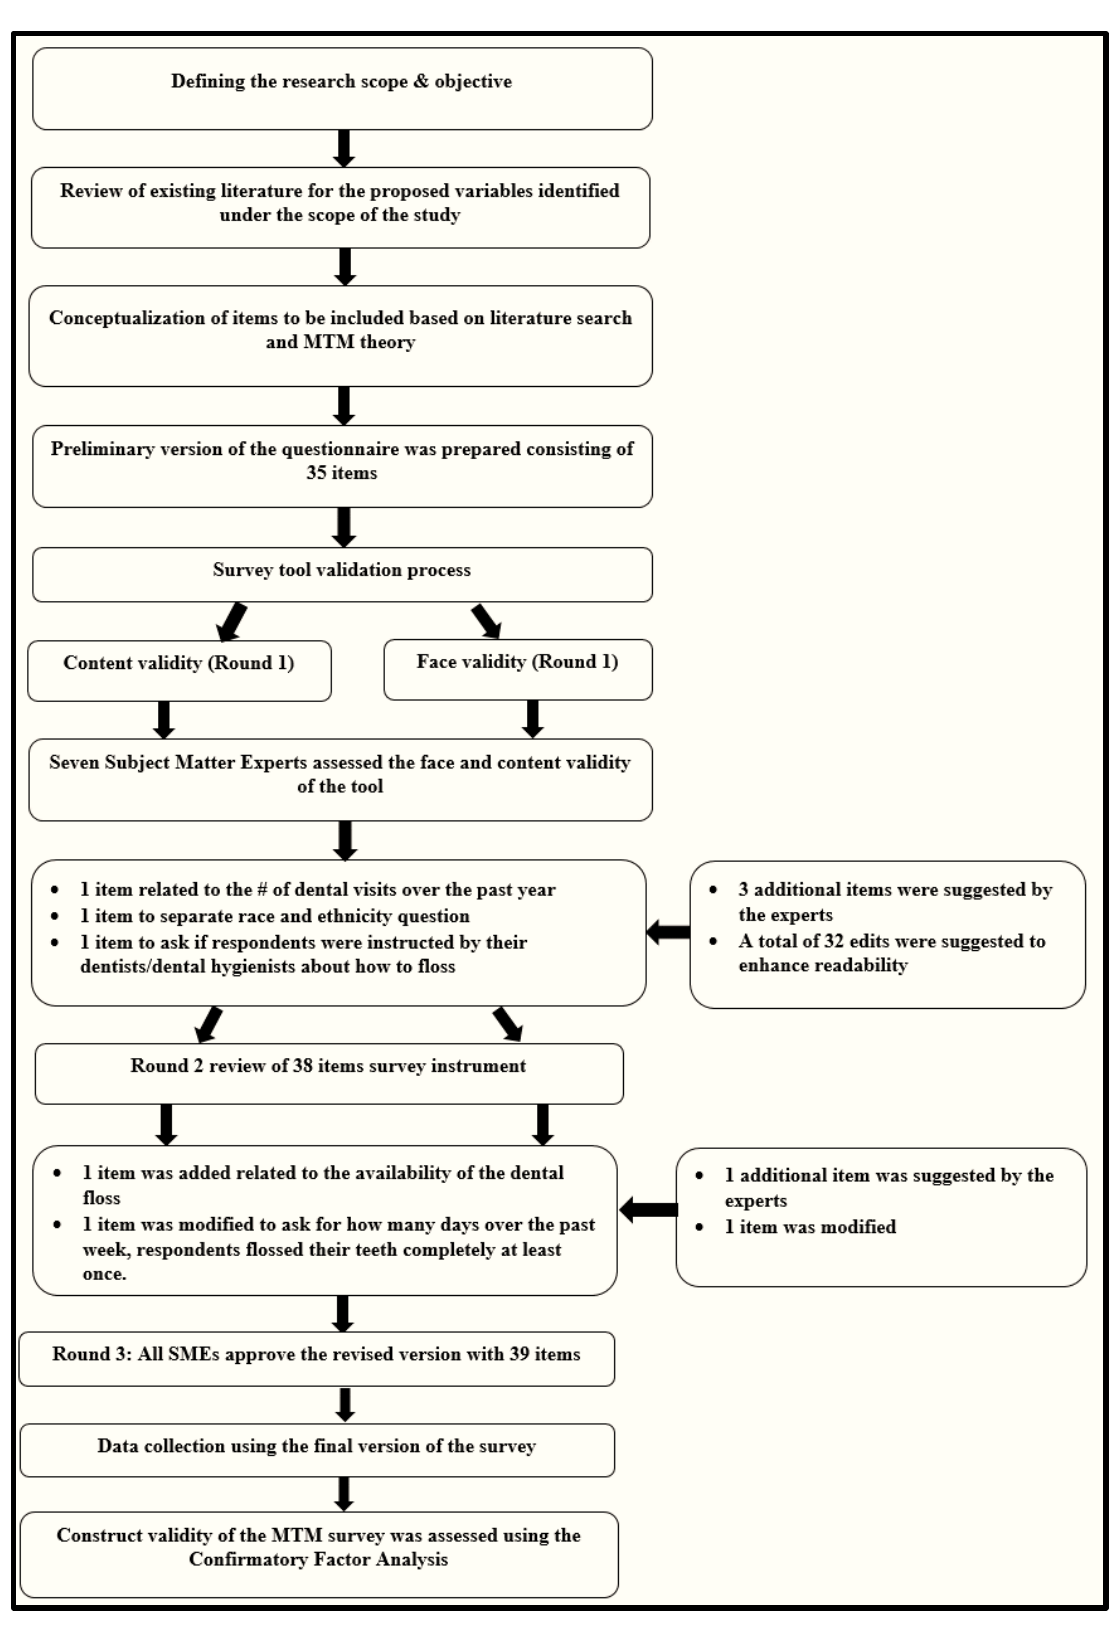
Figure 3. Flow chart depicting the development and validation of the MTM survey tool to measure the change in flossing.